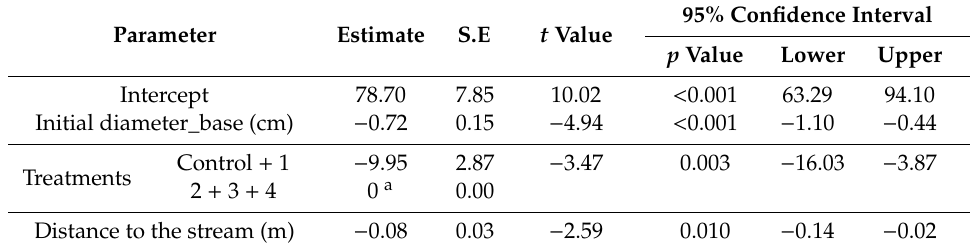
Table 4. Generalized linear mixed model (GLMM) Estimates of the Independent fixed e ff ects on the relative diameter growth at the base (%)”, grouped by plants within blocks as a random e ff ect with a first-order autoregressive structure and combining treatments into two classes, in the experimental plot after the irrigation period. Parameter Estimate S.E t